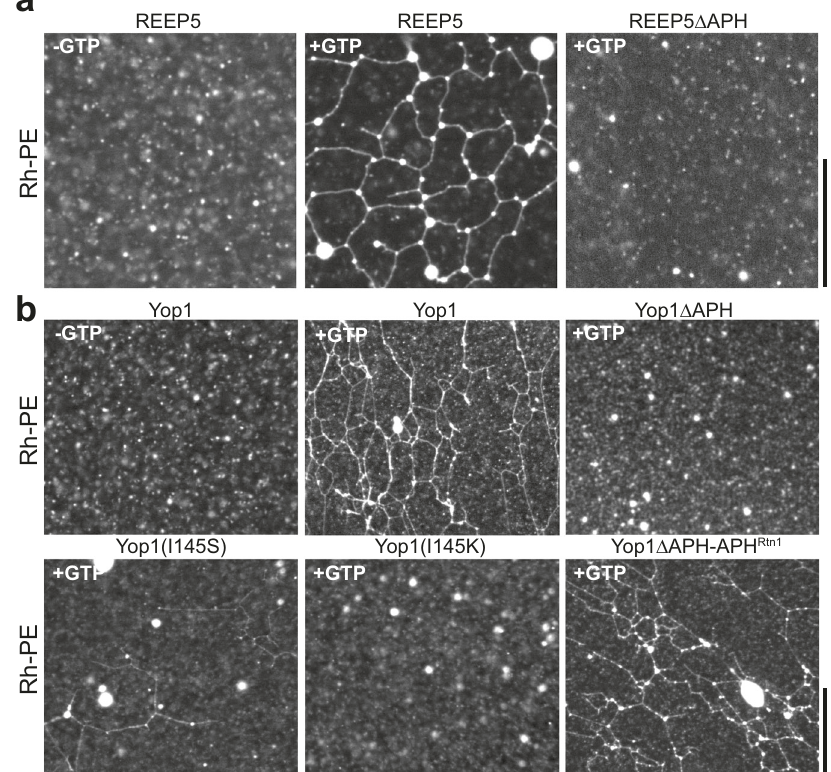
Fig. 5 The APH of REEPs is required for the reconstitution of a tubular network. a Xenopus REEP5 or REEP5 lacking the APH (REEP5 Δ APH) were puri fi ed from DDM-solubilized membranes and co-reconstituted with the GTPase Sey1 into liposomes containing POPC, DOPE, DOPS, and fl uorescent Rh-PE. The samples were incubated with or without GTP, as indicated. The experiment was performed four times. b As in a , but with puri fi ed wild-type Yop1, a Yop1 mutant lacking the APH (Yop1 Δ APH), Yop1 variants with point mutations in the APH (Yop1(I145S) and Yop1(I145K)), or a Yop1 variant, in which the APH was replaced by that of sjRtn1 (Yop1 Δ APH-APH Rtn1 ). Bars (on the right), 10 µ m. The experiment was performed two